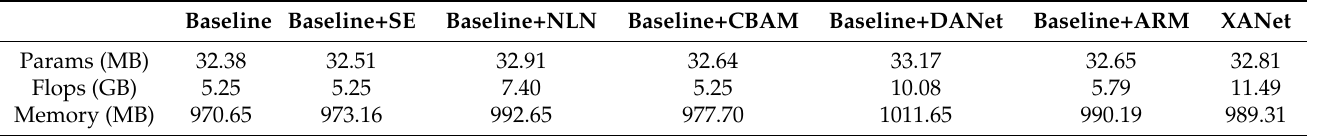
Figure 10. Comprehensive comparison of different attention modules: ( a ) Params ; ( b ) FLOPs ; ( c ) Memory ; and ( d ) mIoU . Table 3. Complexity comparison of different attention